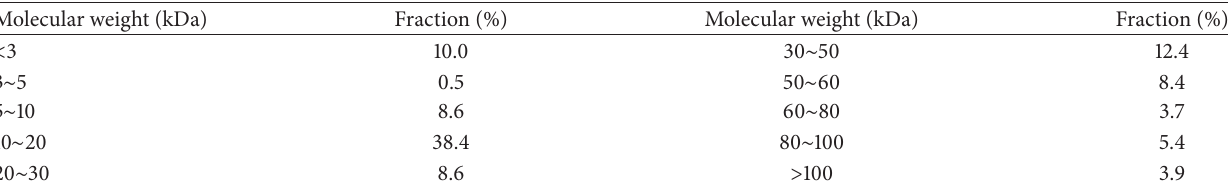
Table 1: Molecular weight distribution of activated sludge biopolymer (ASBP). MW fraction was calculated based on the band intensity of each protein band of CBB-stained SDS-PAGE